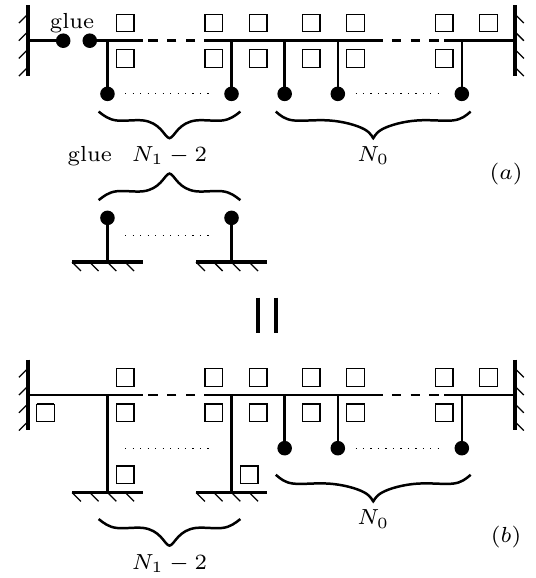
Figure 11 . (b) The basis of N 0 (cid:28) (cid:22) (cid:28) ’s on a surface with N 1 gapped boundaries obtained from the gluing procedure in (a). In (a), the basis of N 0 + N 1 1 (cid:28) (cid:22) (cid:28) ’s on a disk is glued with N 1 1 copies (cid:0) (cid:0) of the basis of one (cid:28) (cid:22) (cid:28) on a disk, and N 1 1 pairs of (cid:28) (cid:22) (cid:28) ’s are annihilated. In (b), each new root (cid:0) acquires a vacancy box for the pseudo-species 2 by the annihilation of a pair of (cid:28) (cid:22) (cid:28) ’s. to eq. (6.1), if we again denote the number of pseudo-species 1 0 by N 1 0 , the pseudo-species 1 0 would contribute the following binomial factor to the statistical weight on the surface with N 1 gapped